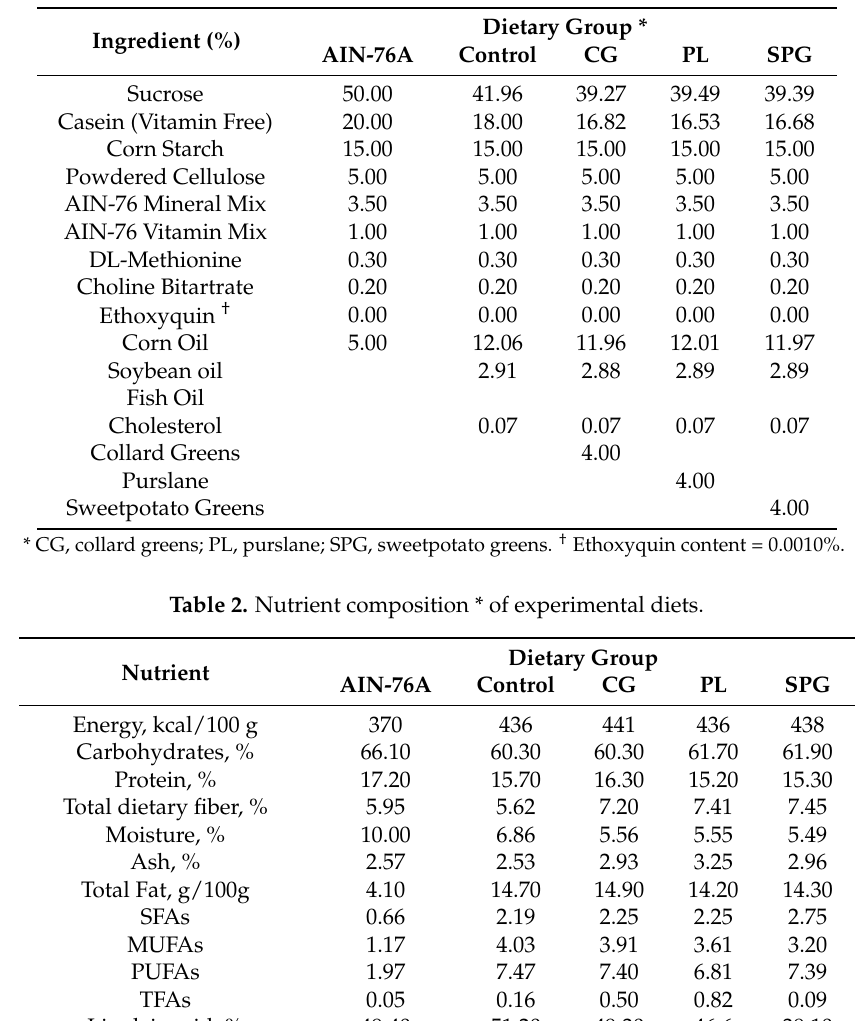
Table 1. Ingredient composition of experimental diets.